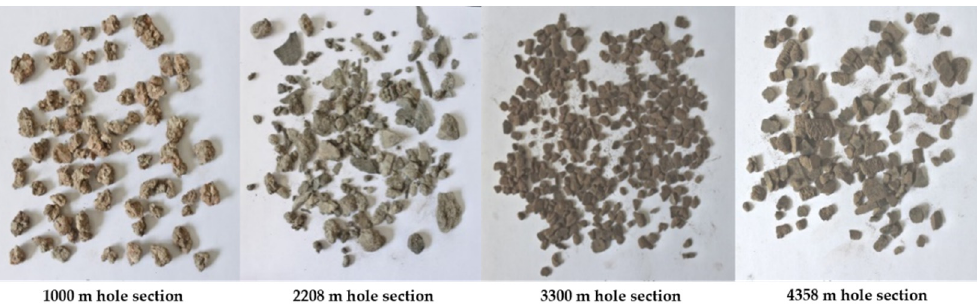
Figure 2. Schematic diagram of shale cuttings morphology in different well sections.